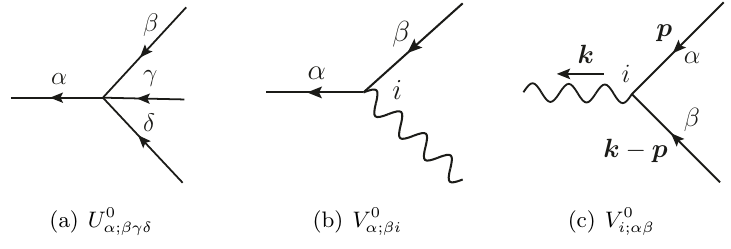
Figure 2 . Interaction